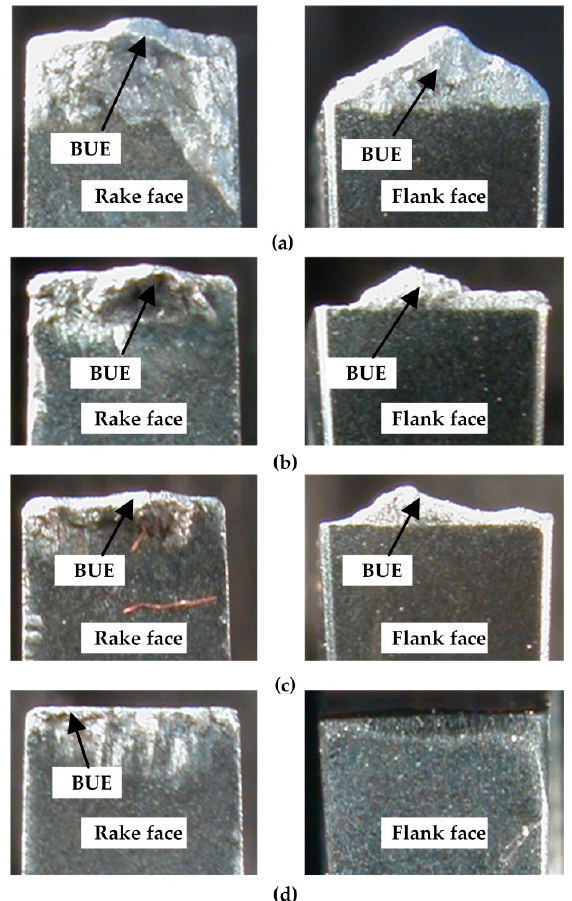
Figure 4. Microscopic images of the DDCC inserts after cutting with various input parameters: ( a ) v c = 180 m / min, f = 0.2 mm / rev, VB B = 0.04 mm; ( b ) v c = 400 m / min, f = 0.2 mm / rev, VB B = 0.04 mm; ( c ) v c = 600 m / min, f = 0.2 mm / rev, VB B = 0.04 mm; ( d ) v c = 800 m / min, f = 0.15 mm / rev, VB B = 0.05 mm.